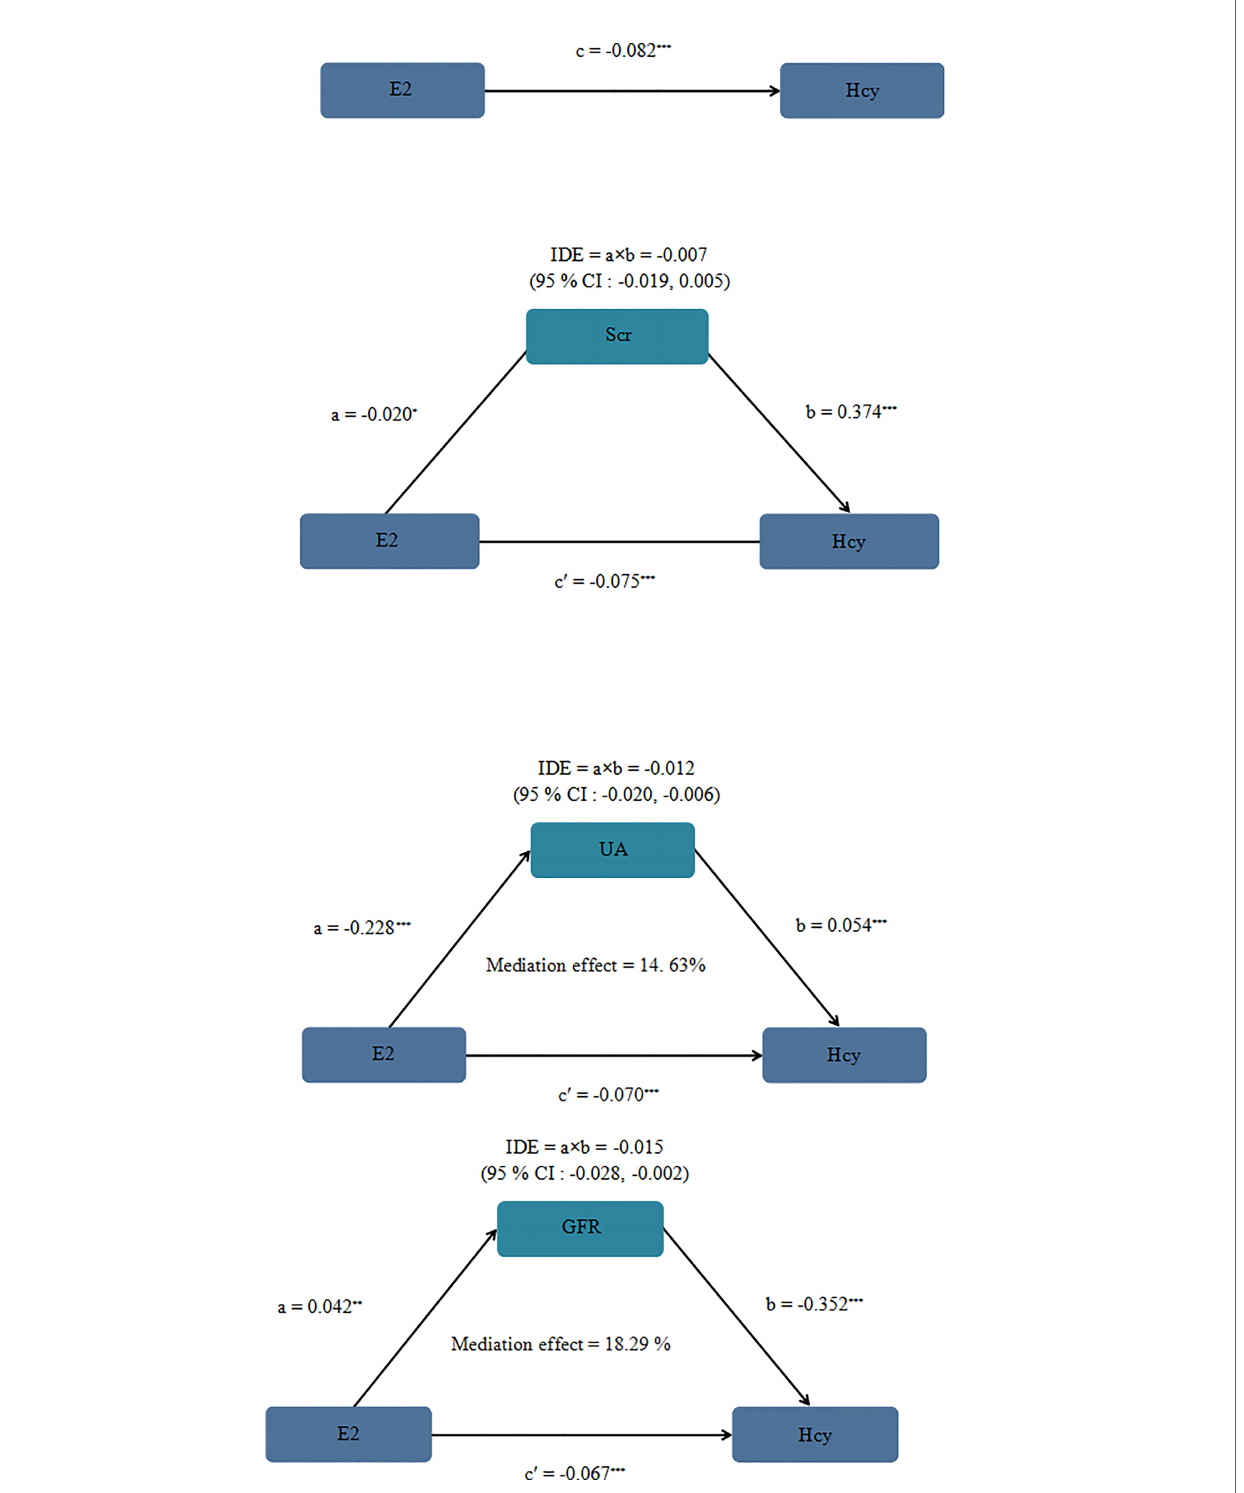
Frontiers in Endocrinology |